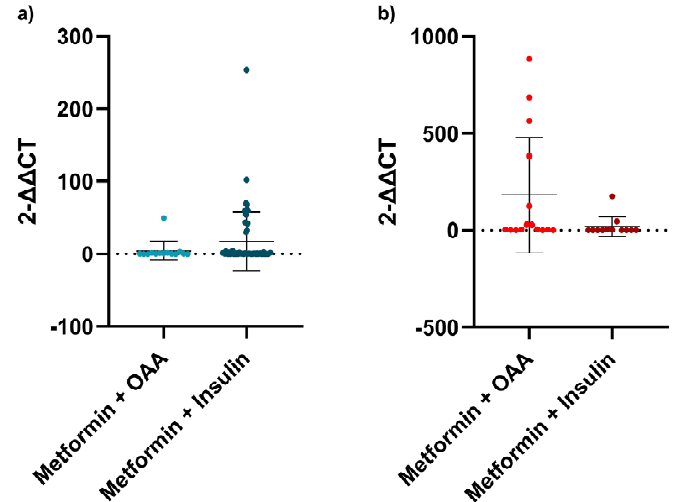
Figure 3. Antidiabetic agents and telomere length. ( a ) Telomere length comparison between metformin plus other antidiabetic agent and metformin plus insulin in the LADA group; ( b ) Telomere length comparison between metformin plus other antidiabetic agent and metformin plus insulin in the T2DM group. For this analysis, Mann-Whitney test was used. All patients in LADA and T2DM groups were divided according to the medical records of which antidiabetic agents were used by each patient. Error bars represent the standard deviation.